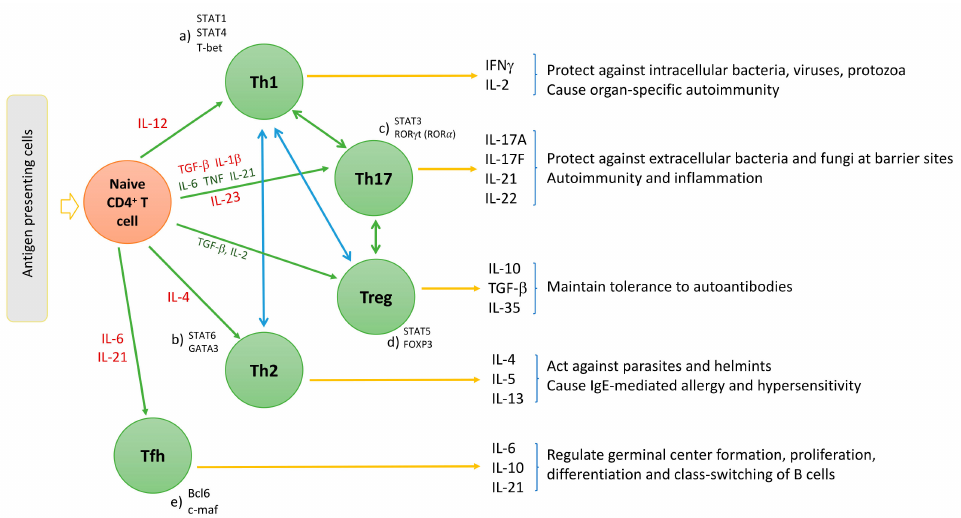
Figure 1. Di ff erentiation of naïve CD4 + cells into Th1, Th2, Th17, regulatory T cells (Treg), and